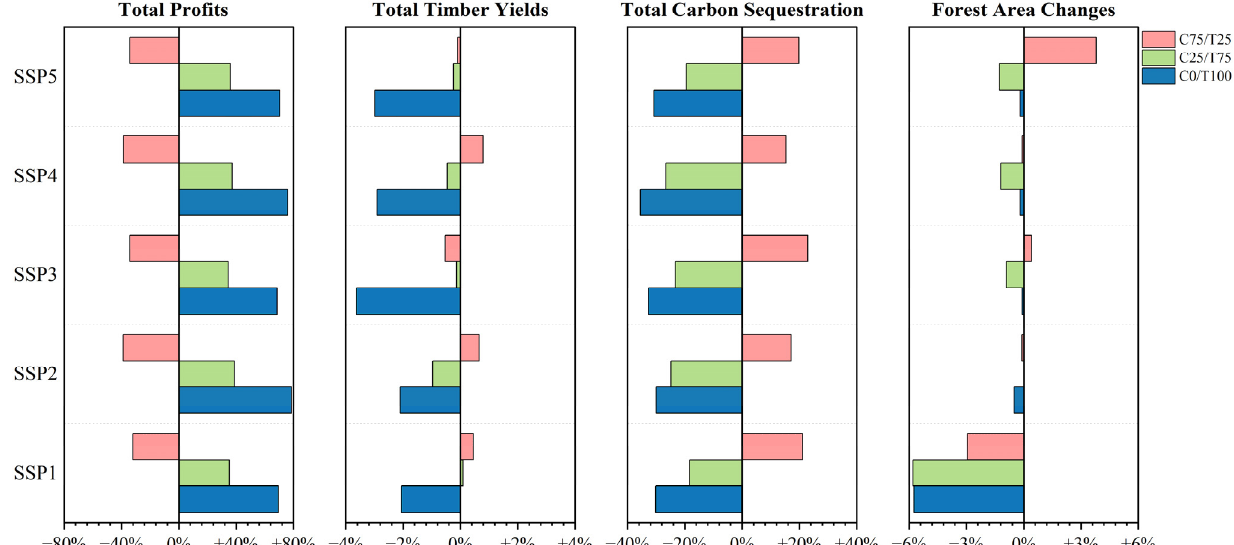
Figure 5. Key model estimates for weight parameter sensitivity in all SSPs. Forest area, total carbon sequestration, total timber yield, and total profits are selected in this study and listed above. The bars in pink, green, and blue colors represent the changes in percentage between weight sensitivity analysis and the SSP2. C75/T25, C25/T75, C0/T100 represent that the carbon weights are 75%, 25%, and 0%, while the timber weights are 25%, 75%, and 100%, respectively.